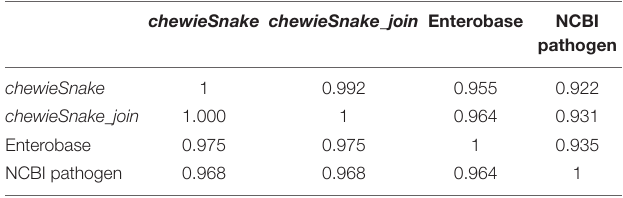
TABLE 1 | (Direction-dependent) adjusted Wallace coefficient for all method comparisons.